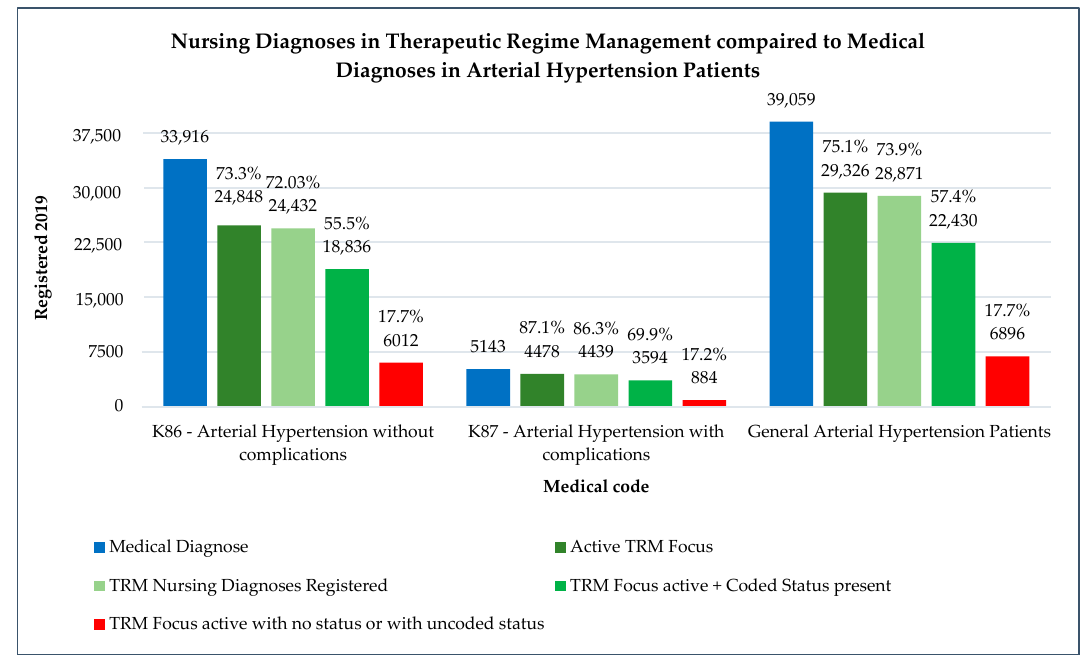
Figure 4. Nursing diagnoses in Therapeutic Regimen Management compared with medical diagnoses in arterial hypertension patients.